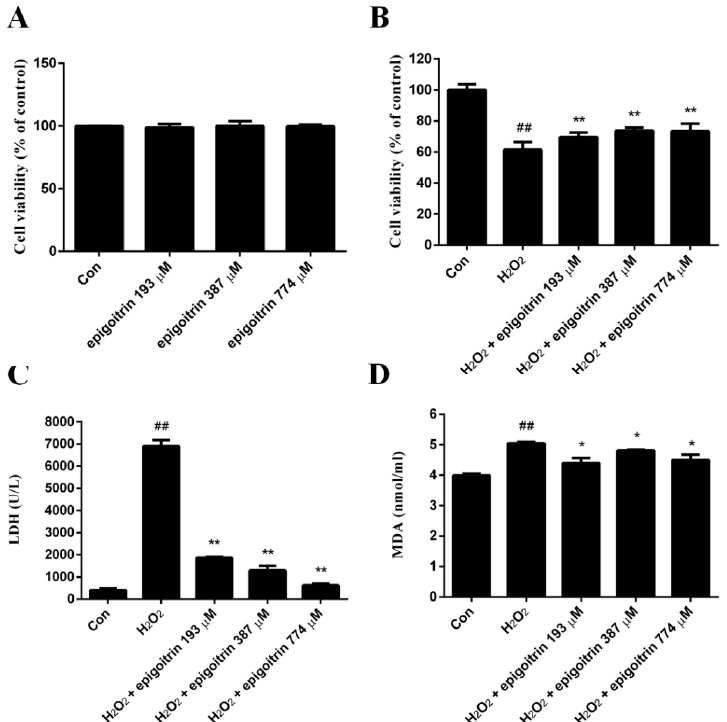
Figure 6. Cytoprotective effect of epigoitrin against H 2 O 2 -induced HepG2 cells. ( A ) Effect of epigoitrin on HepG2 cells viability determined by 3-(4,5-dimethylthiazol-2-yl)-2,5-diphenyltetrazolium bromide (MTT) assay. Cells were cultured with different concentrations of the epigoitrin (193, 387, and 774 µ M) for 12 h. Values are the means ± SEM of three independent experiments; ( B ) Effect of epigoitrin on the viability of HepG2 cells with H 2 O 2 exposure. Cells were incubated with H 2 O 2 (0.4 mM, for 2 h) after pretreatment with epigoitrin (193, 387, and 774 µ M) for 12 h. The cell viability was determined by the MTT assay. Values are the means ± SEM of three independent experiments. ## p < 0.01 versus control (untreated cells), ** p < 0.01 versus H 2 O 2 -treated cells. Effect of epigoitrin on lactate dehydrogenase (LDH) ( C ) and malondialdehyde (MDA) ( D ) levels in H 2 O 2 -induced HepG2 cells. Values are the means ± SEM of three independent experiments. ## p < 0.01 versus control (untreated cells), ** p < 0.01, * p < 0.05 versus H 2 O 2 treated